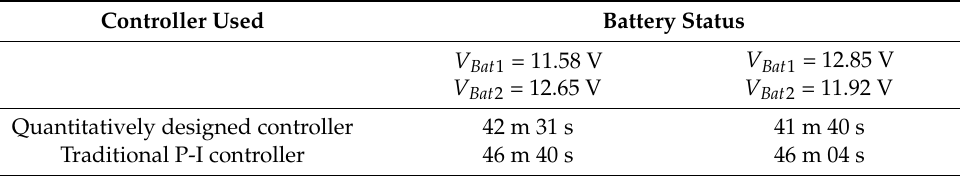
Figure 19. Equalizing discharge control response of the quantitatively designed controller when V Bat1 = 13.29 V and V Bat2 = 12.44 V: ( a ) initiate equalizing discharge control; ( b ) reach equalizing discharge equalization. Table 5. Comparison of equalizing charge time between the quantitatively designed controller and traditional P-I